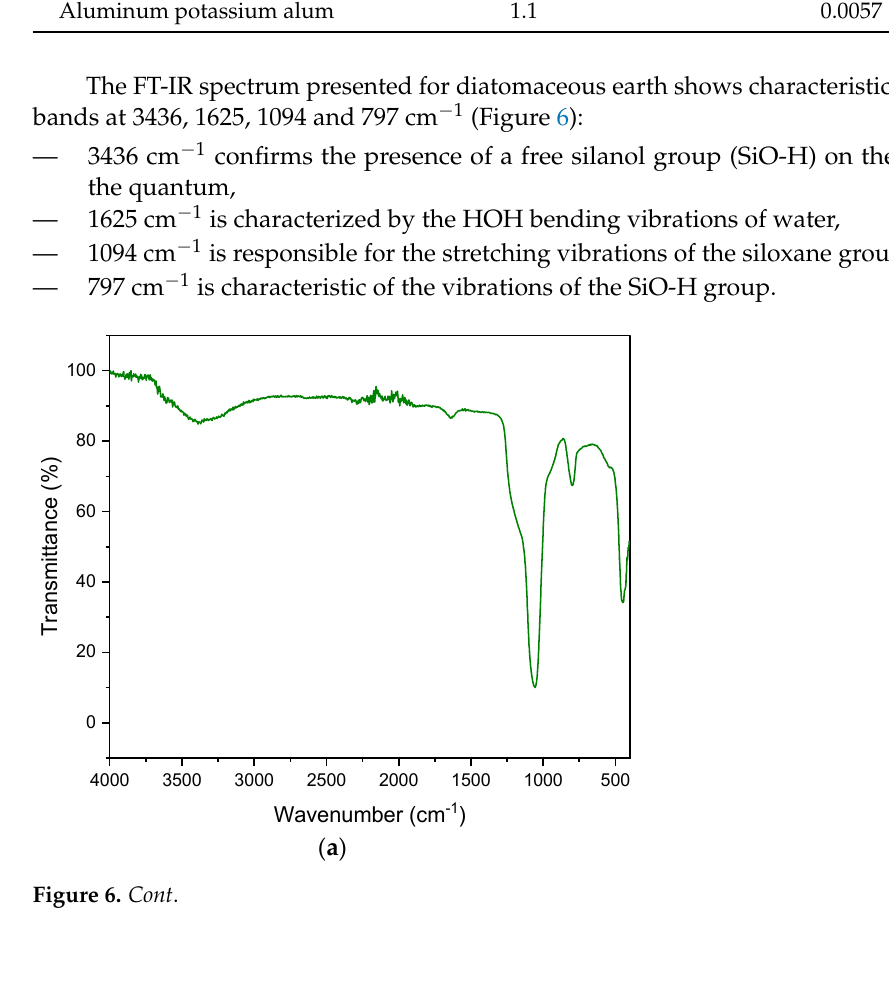
Figure 5. X-ray diffraction data for catalysts. Table 3. Properties surfaces of the tested materials. Catalyst BET, m 2 /g V por , cm 3 /g Diatomite 33.6 0.1233 Aluminum potassium alum 1.1